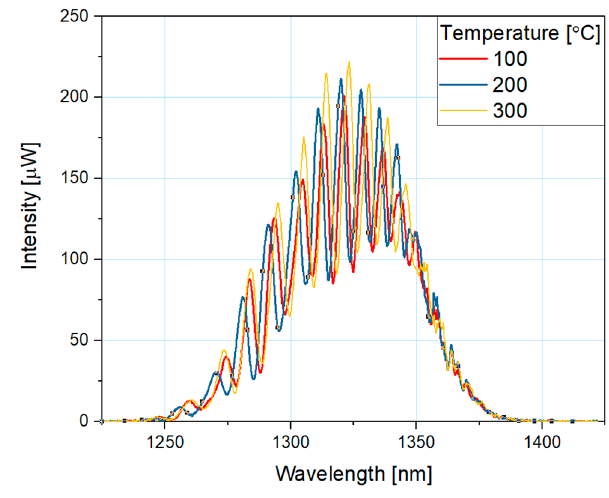
Figure 4. Measured response of the reflected signal intensity for the microsphere-based sensor with 200 nm ZnO ALD coating at 100, 200 and 300 °C.